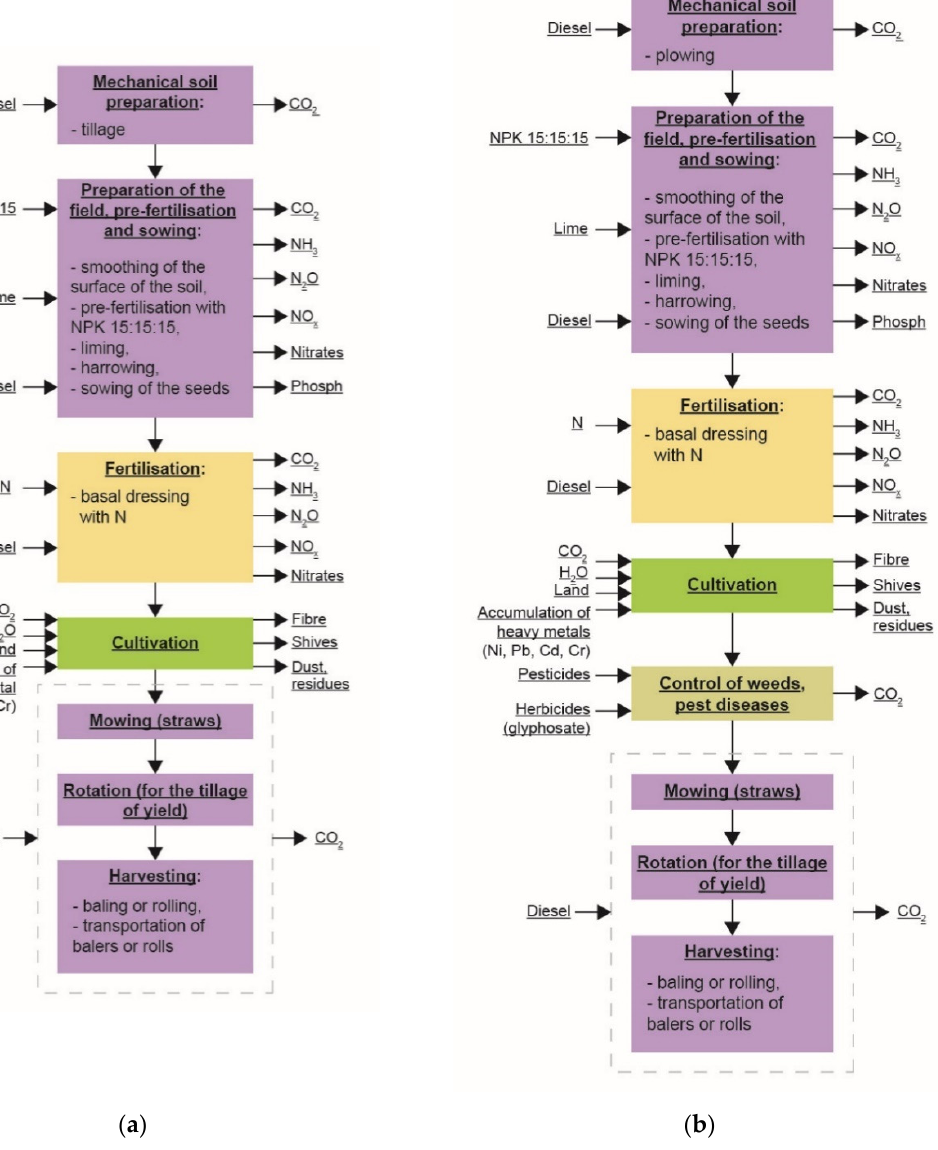
Figure 2. A sequential schematic representation of the processes with inputs and outputs in the cultivation of fiber crops: ( a ) hemp; ( b ) flax.